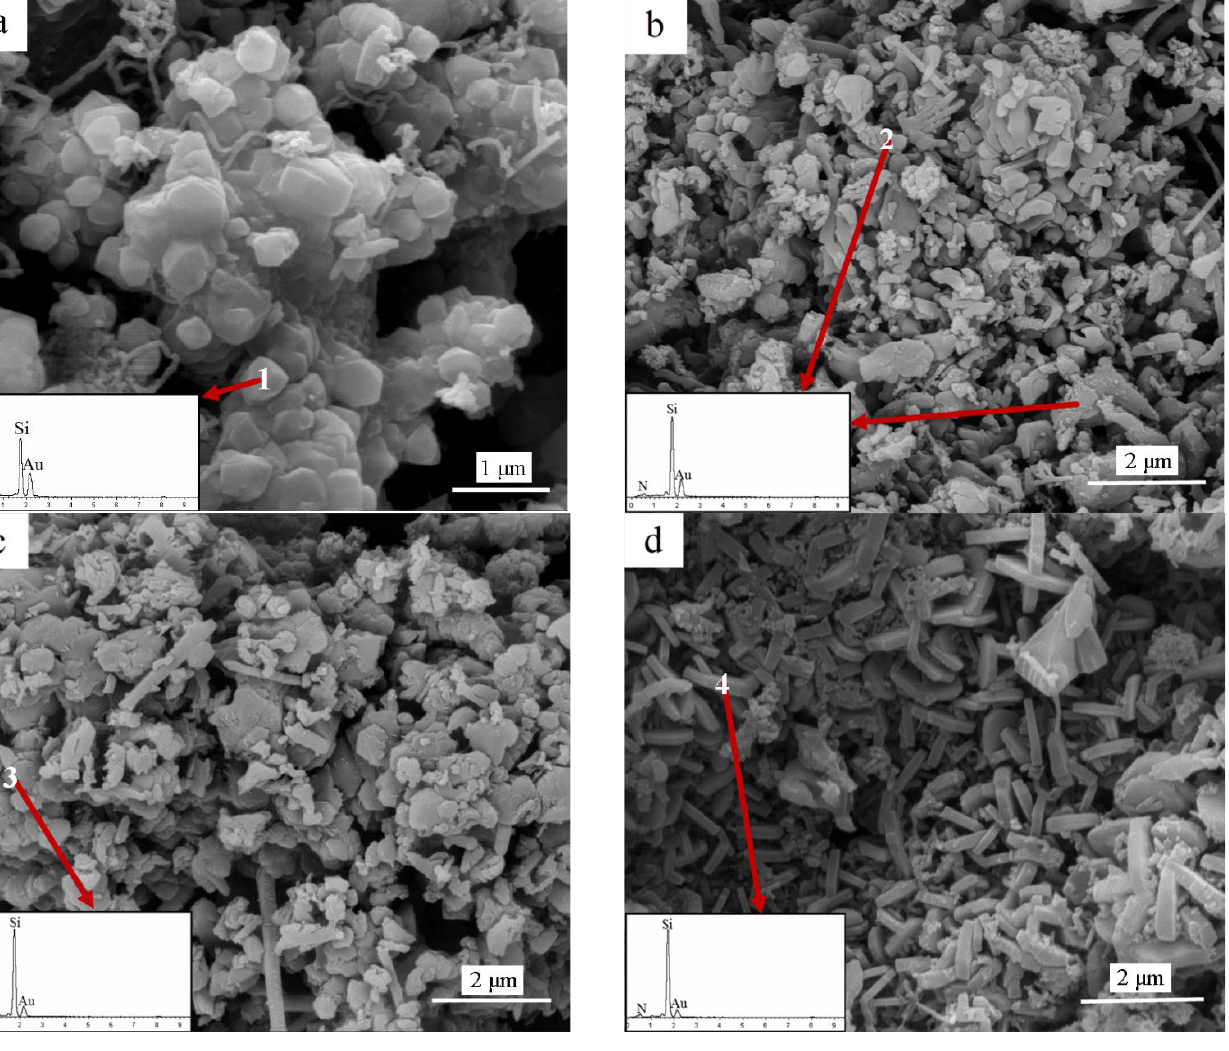
Figure 4. SEM images and EDS analysis (insets) of final products obtained by nitridation at 1250 °C for 5 h, using various catalysts. ( a ) catalyst-free, ( b ) Fe catalyst, ( c ) Co catalyst, ( d ) Ni catalyst. The red arrows and the numbers indicate the location of the analysis. Table 1. Microarea percent ratio of points 1, 2, 3, and 4 in Figure 4/Atomic%.